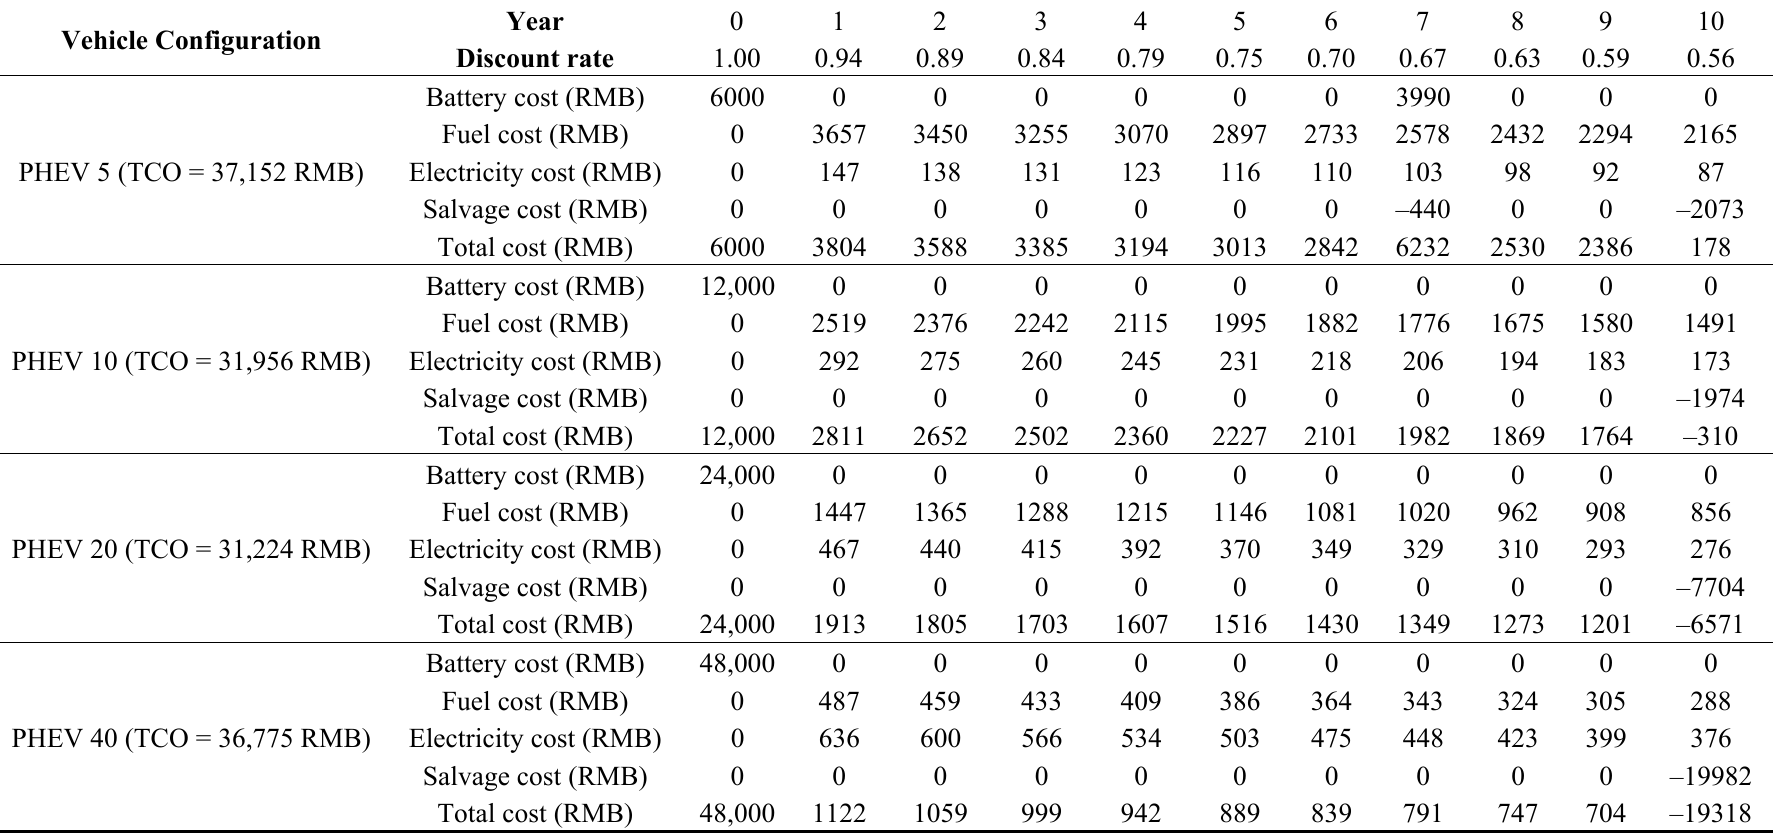
Table 2. The cash flows for the sub-costs during the evaluation